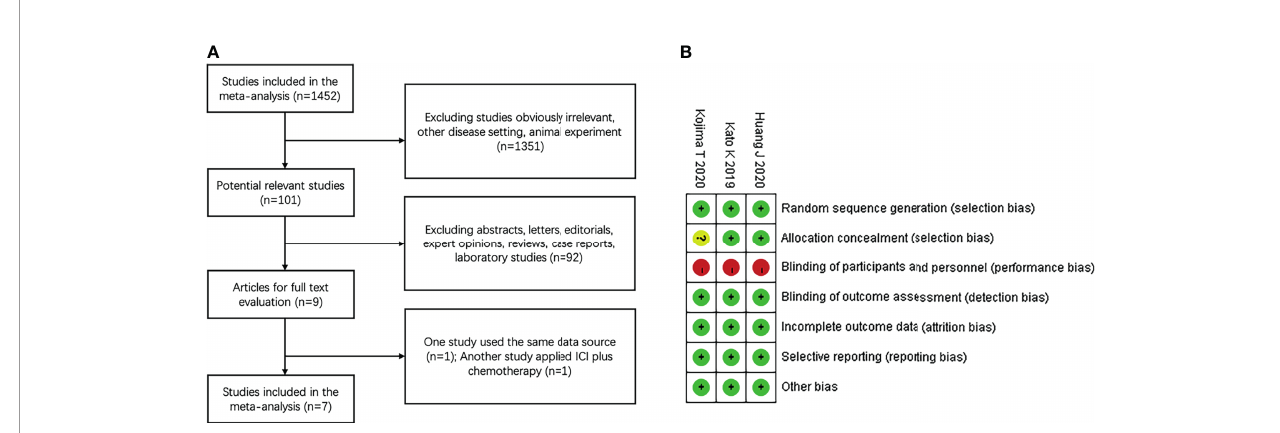
FIGURE 1 | Study identi fi cation and risk of bias (A) Flow diagram of identi fi cation of relevant studies; (B) Summary of risk of bias summary of randomized controlled trials. + low risk,? unclear risk, – high